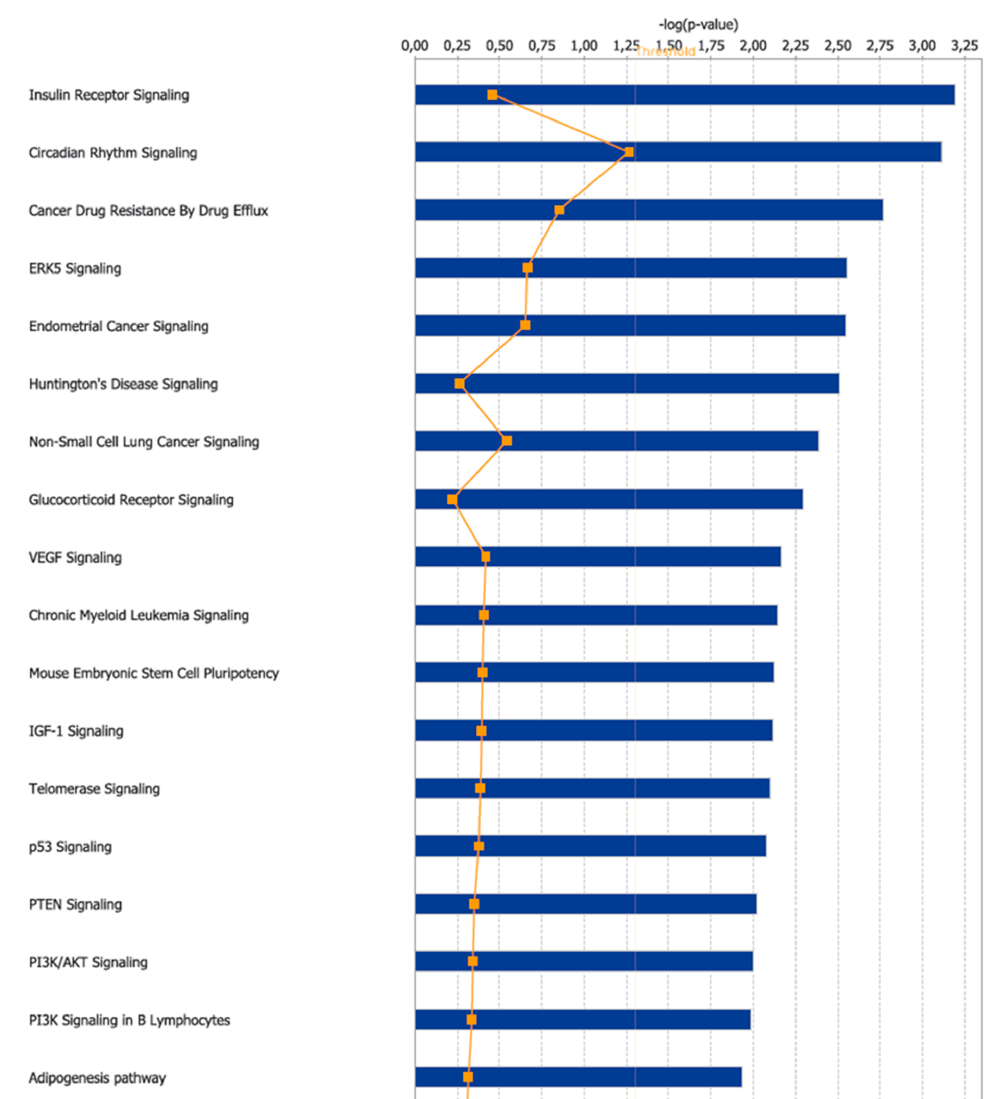
Figure 2. Top 18 canonical pathways enriched by the Ingenuity Pathway Analysis software (IPA) "Core Analysis" for the 25 genes differentially expressed between the CTRL and RS groups.